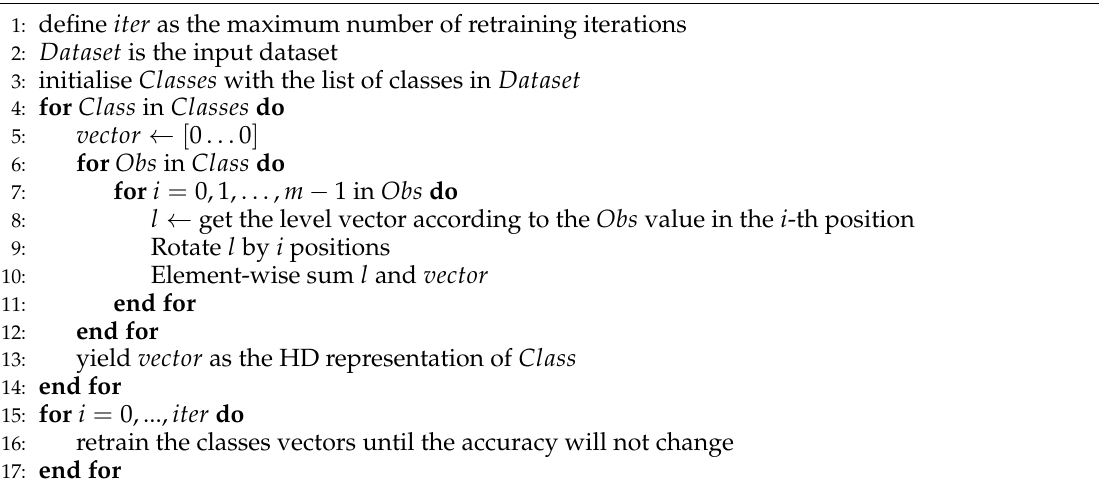
Algorithm 1 Encoding observations to class